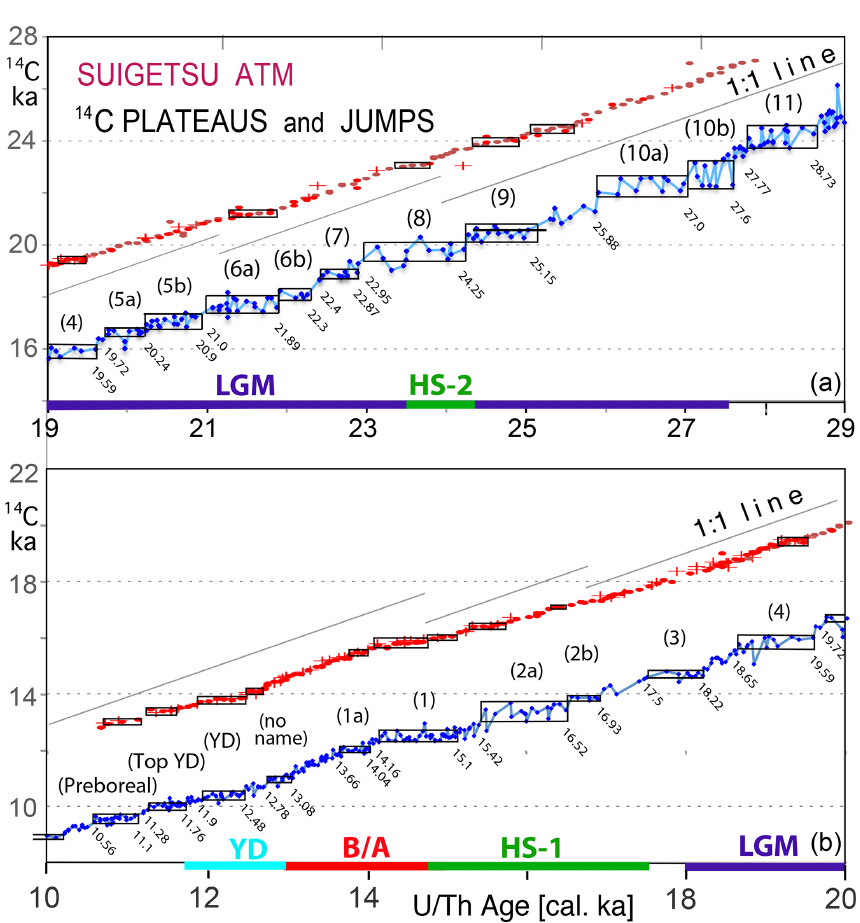
Figure 1. Atmospheric 14 C ages of Lake Suigetsu plant macrofossils from 10–20calka (b) and 19–29calka (a) vs. U / Th-based model age (blue dots; Bronk Ramsey et al., 2012). The 1 : 1 line reflects a gradient of 1 14 C year per 1calyr. Double and triple 14 C measurements are averaged. Large (in part) error bars of single 14 C ages are given in Fig. S1 in the Supplement. A suite of labeled horizontal boxes that envelop scatter bands of largely constant 14 C ages shows 14 C plateaus longer than 250 years (plateau boundary ages listed in Table 1). Red and brown dots (powder samples from the trench and wall) and + signs (off-axis samples) depict raw 14 C ages of Hulu stalagmites H82 and MSD (Cheng et al., 2018; Southon et al., 2012; plot offset by + 3000 14 C years). A suite of short 14 C plateaus (black boxes) tentatively assigned to Hulu-based record occupies age ranges slightly different from those deduced for Suigetsu-based plateaus. The difference possibly results from short-term changes in the Old or Dead Carbon Fraction (OCF or DCF, respectively) that in turn may reflect major short-term changes in LGM and deglacial monsoon climate (Wang et al., 2001; Kong et al.,